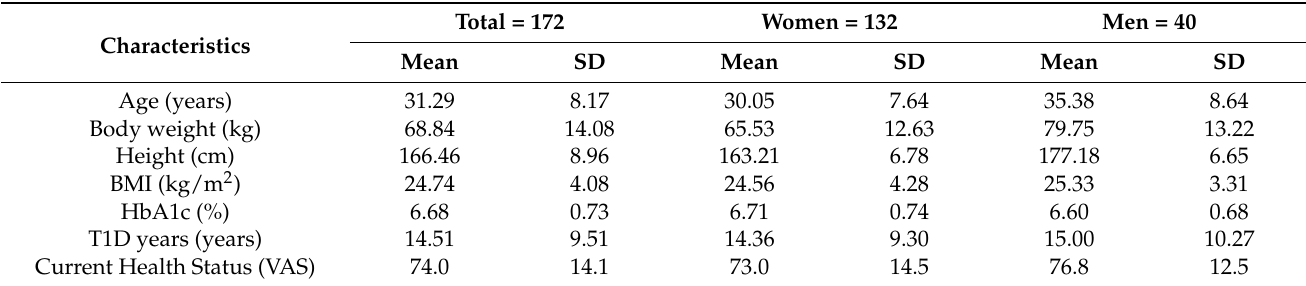
Table 1. Participant